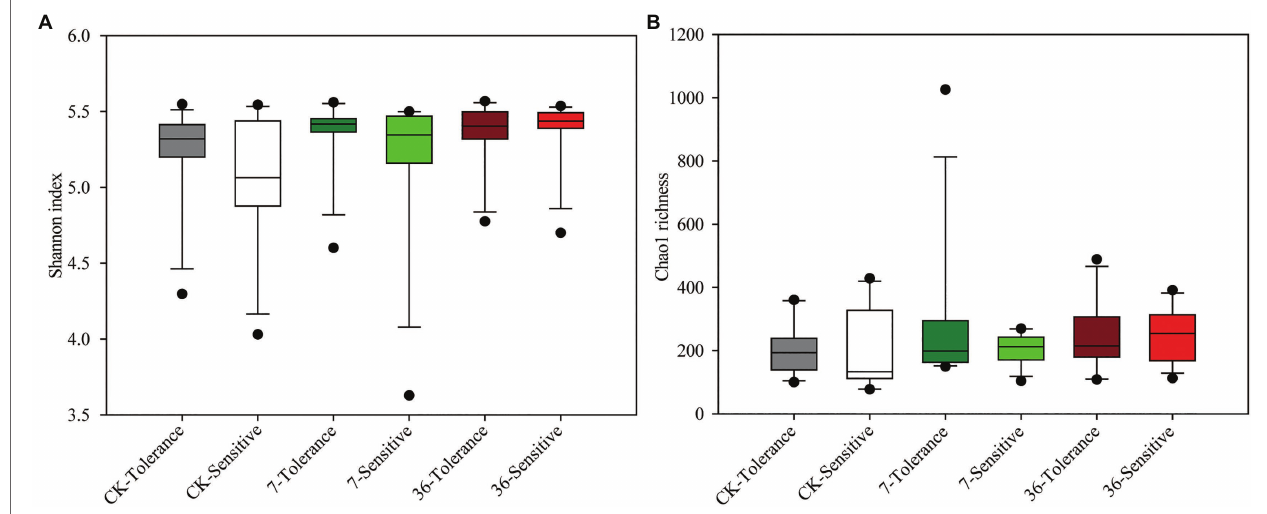
TABLE 2 | Effects of cropping systems and soybean genotypes on the differentiation of bacterial communities based on PERMANOVA. Factor F R 2 p Cropping systems